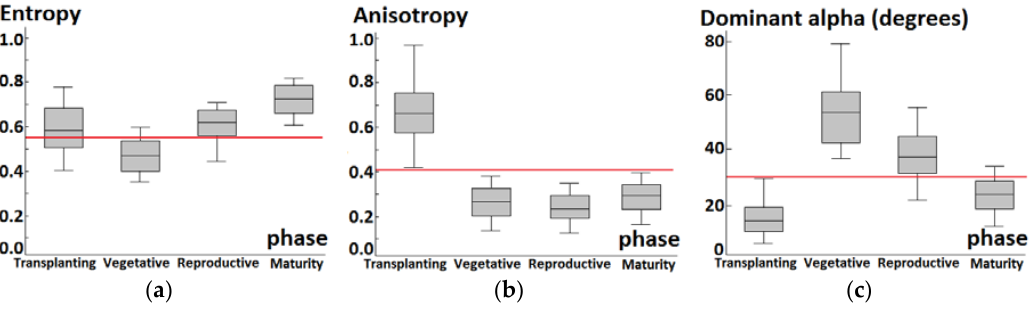
Figure 10. Evolution of observables (training dataset) provided by the eigenvalue/vector decomposition of the coherency matrix versus phenology, ( a ) Entropy, ( b ) Anisotropy, ( c ) Dominant alpha angle ( α 1 , alpha of the dominant scattering mechanism). Red lines represent possible division values to separate at least two interquartile ranges (grey part of boxes).